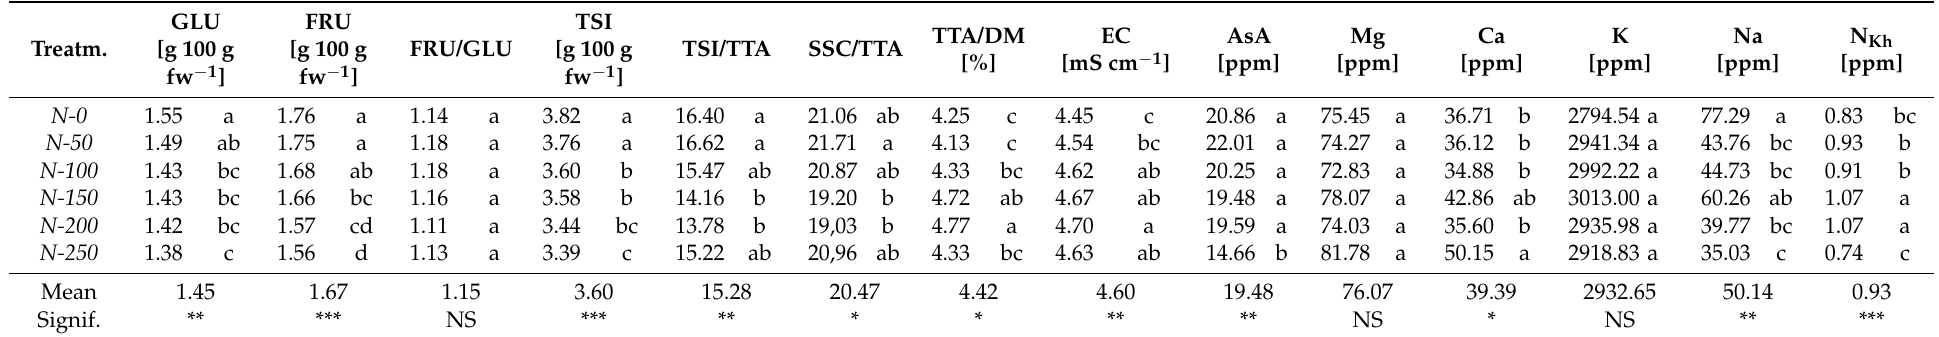
Table 2. Effects of nitrogen fertilization (N-0, N-50, N-100, N-150, N-200, and N-250) on sugars, quality indexes, electrical conductivity, ascorbic acid, and mineral contents of tomato fruits, cv